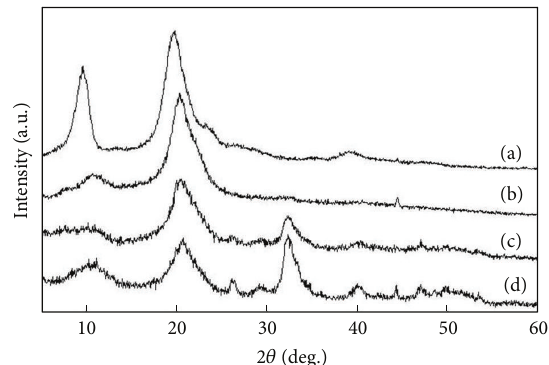
Figure 1: XRD patterns of (a) chitosan fiber as well as (b) 10/90, (c) 20/80, and (d) 30/70 HAp/chitosan hybrid